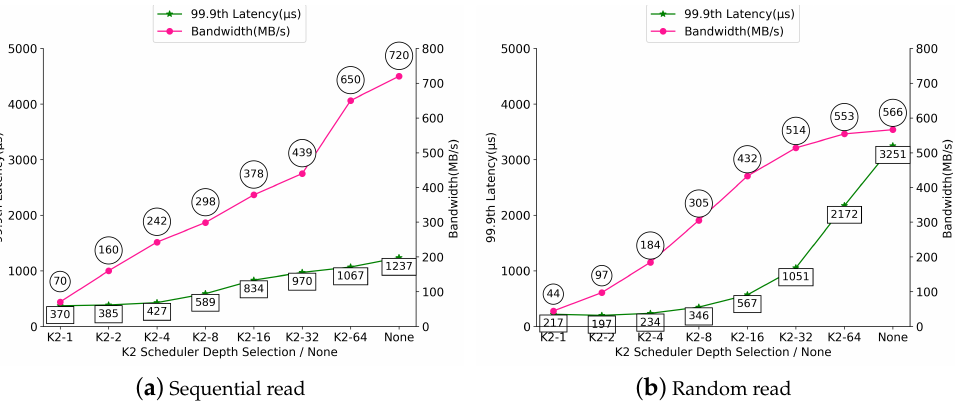
Figure 4. Performance of sequential/random read operations on a partially occupied